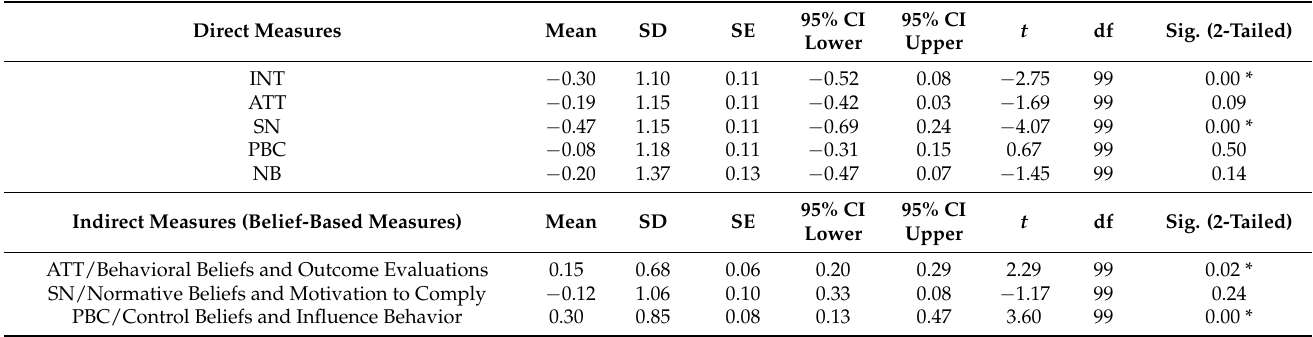
Table 10. Results of the Paired Samples t -tests between Pre-feedback and interventions and Post- feedback Scores of the Experimental